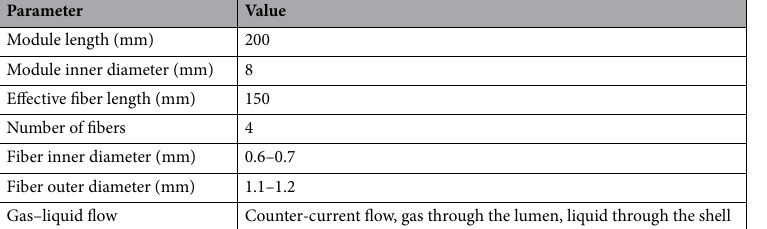
Table 3. Characteristics of membrane contactors.